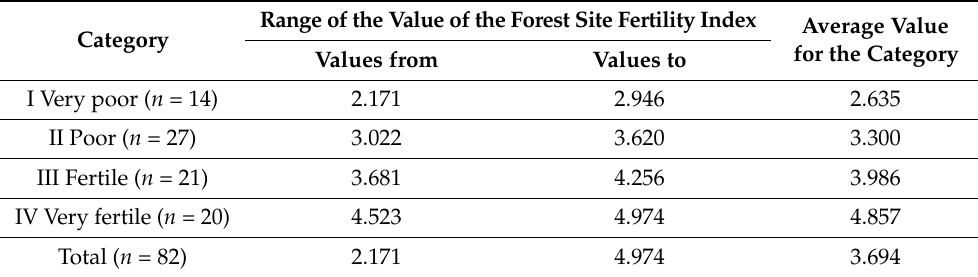
Table A2. Categories of forest districts distinguished on the basis of the fertility of forest site types. Range of the Value of the Forest Site Fertility Category